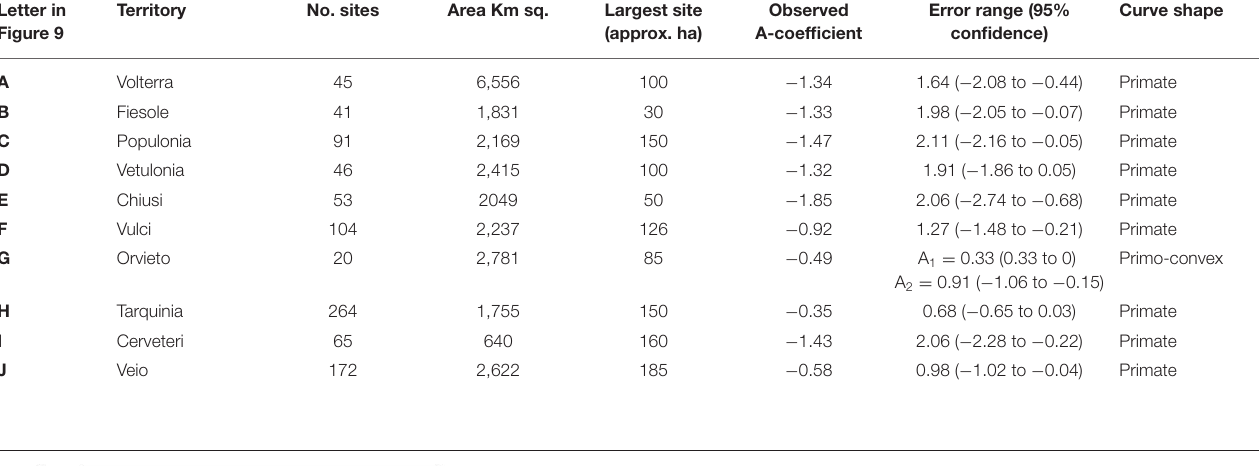
Observed Error range (95% Curve shape (approx. ha) A-coefficient confidence)